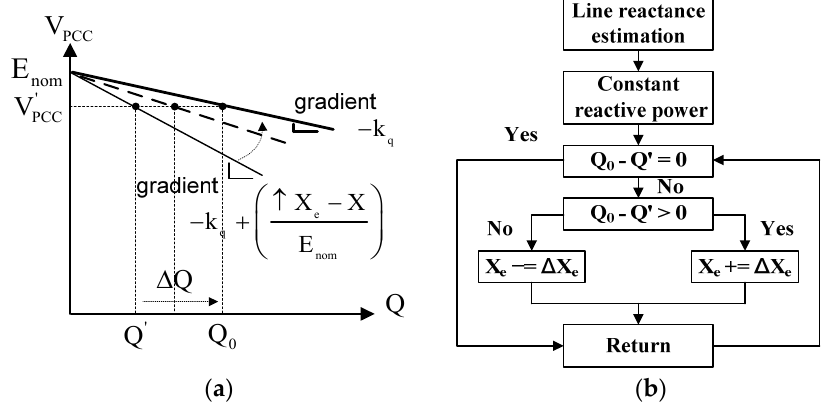
Figure 7. Algorithm for line reactance estimation: ( a ) Principle; ( b ) Estimation flow.